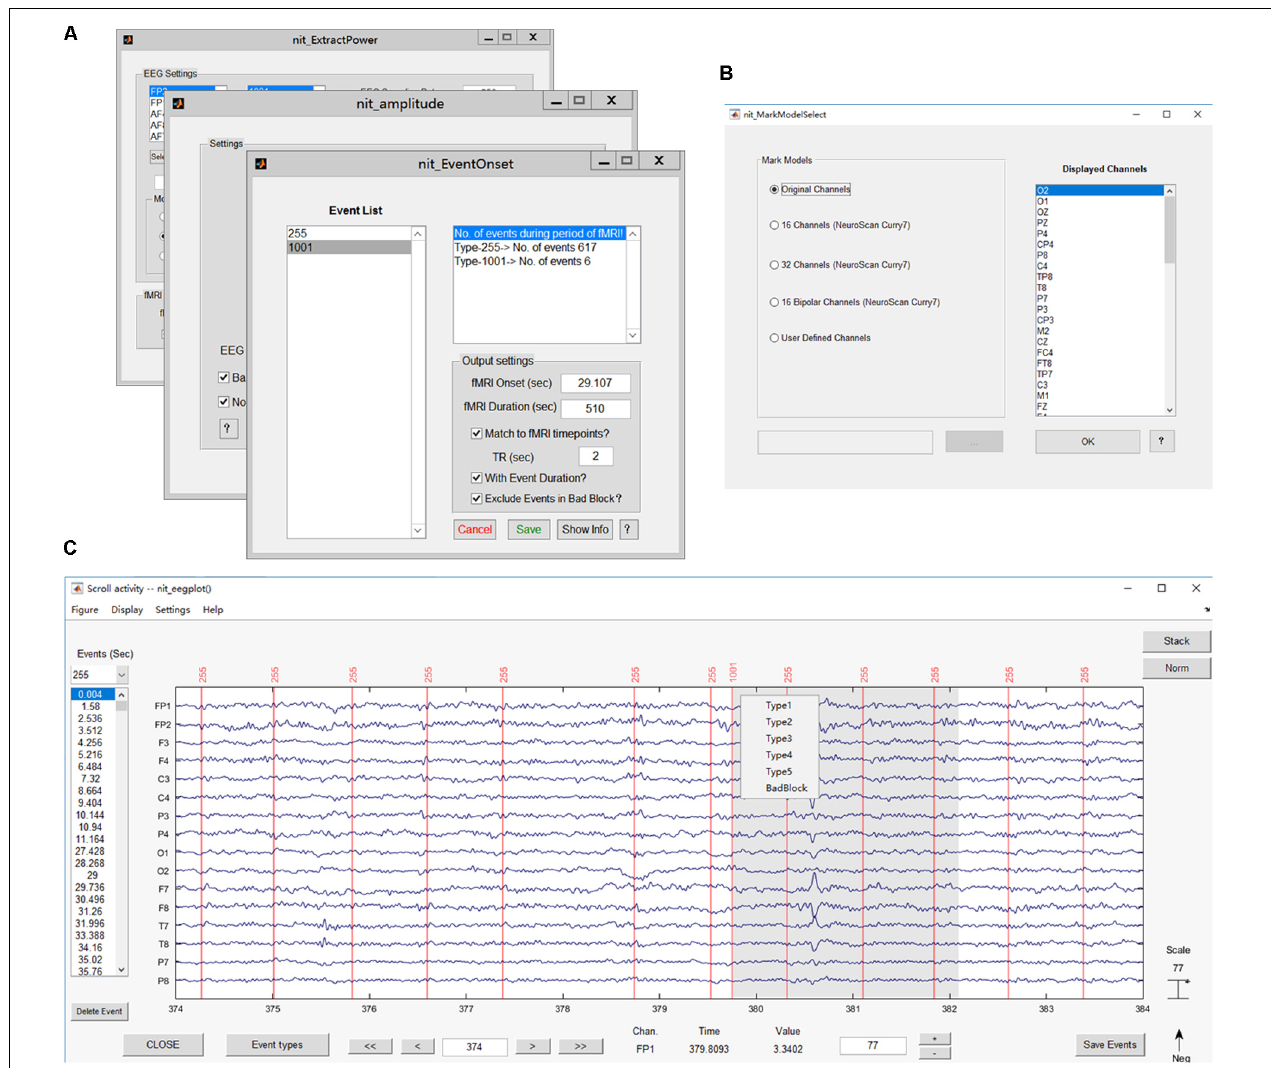
FIGURE 6 | Main functions of the EEG module. (A) Interfaces for extracting EEG features, including onsets, power values and ERP amplitudes; (B) interface for selecting the channels to show; (C) plotting the EEG figure and marking interesting events (e.g., added label